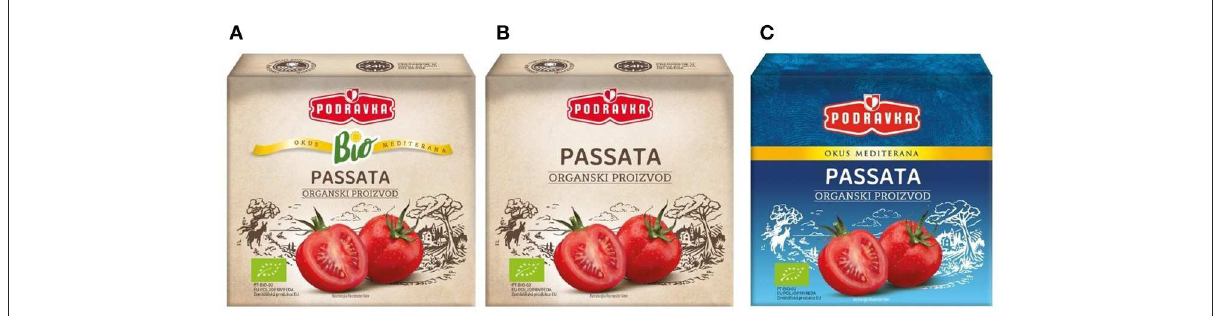
FIGURE1 Passata in original BIO packaging, sold in stores (A) , original color combination but without the BIO label, not sold in stores (B) , and manipulated color combination, not sold in stores (C) . Images copyright protected by Podravka. All manipulations with color and color inversions on products were made by Podravka exclusively for the purposes of this research.